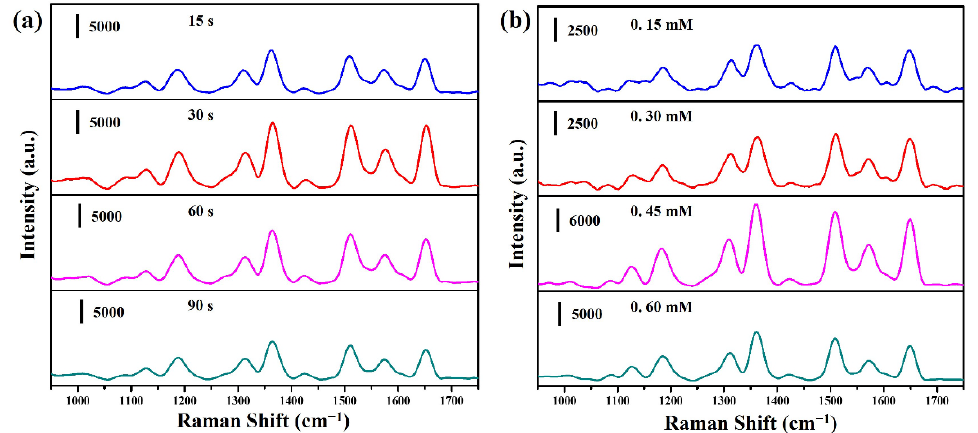
Figure 6. ( a ) SERS spectra of R6G (10 − 6 M) on CuO@Ag nanowires grown at different sputtering times. ( b ) SERS spectra of R6G (10 − 6 M) on CuO@RF@Ag nanowires grown at different concentrations of AgNO 3 solution.